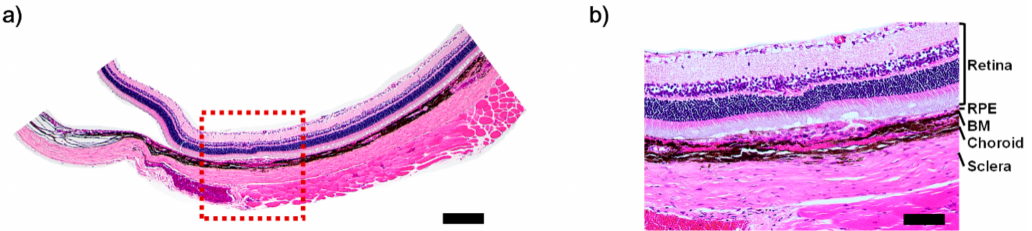
Figure 5. Histology image of a rat with subretinal implanted BMS. ( a ) H&E staining of the implanted BMS. ( b ) Magnification of subset (red box). Scale bars: ( a ) 500 µ m; ( b ) 100 µ